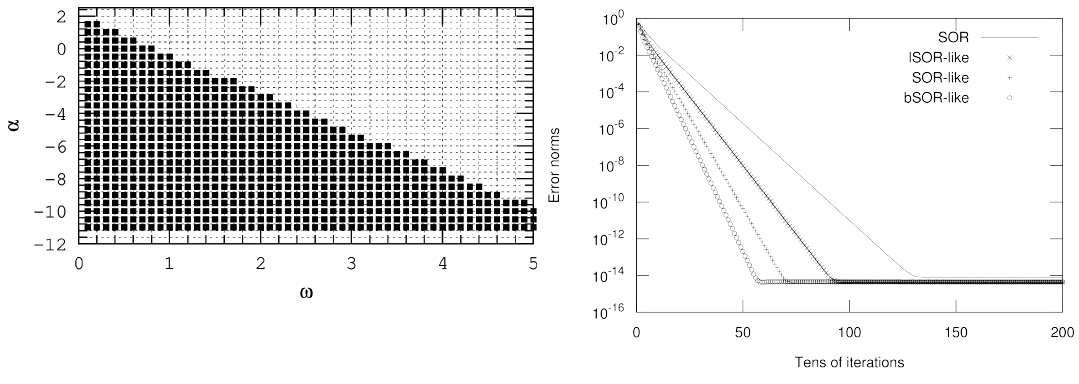
Fig. 3. Pairs .˛;!/ for which bSOR-like converged. Fig. 4. Convergence comparison for .˛;!/ D . (cid:0) 0:5;0:8/